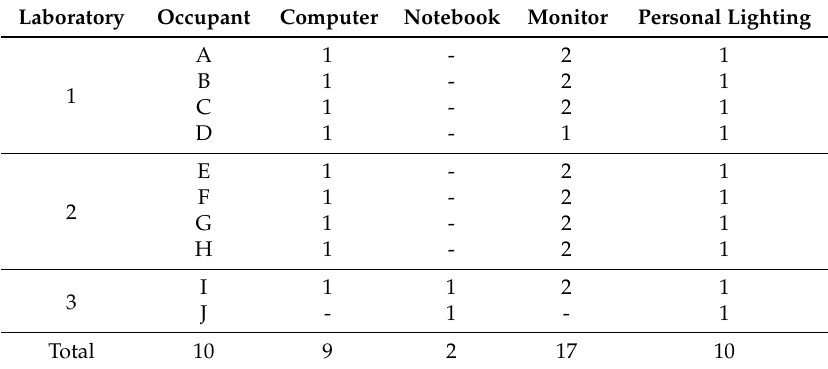
Table 1. Occupants and plug-in devices.